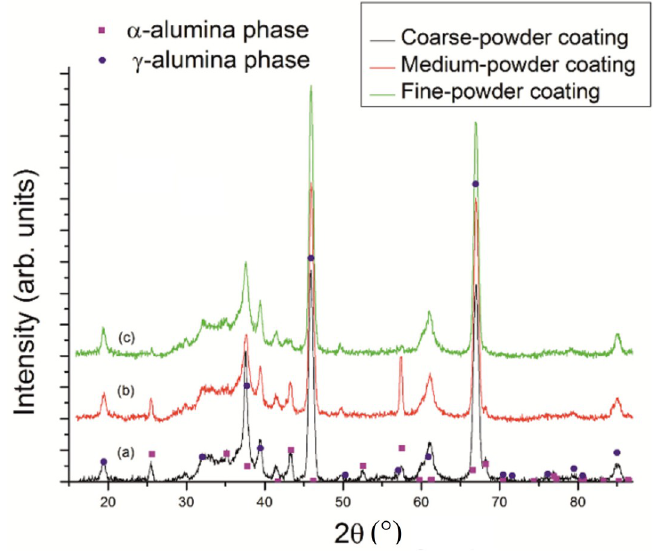
Figure 6. X-ray powder di ff raction (XRD) patterns of APS alumina coatings deposited with ( a ) coarse-powder, ( b ) medium-powder, and ( c ) fine-powder particle